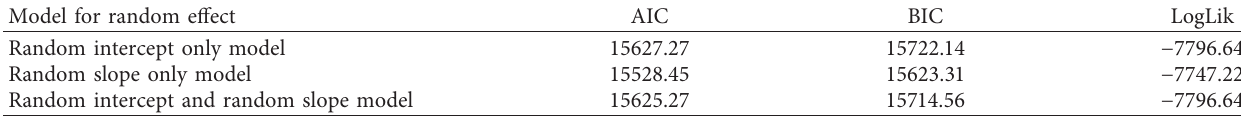
Table 4: Selection of random effects to be included in the LMM for PR and RR CHF patients’ data.